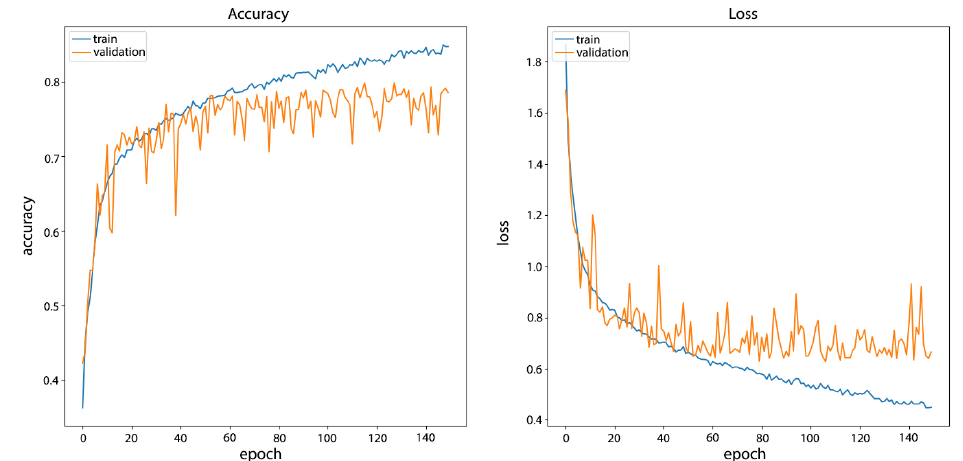
Figure 7. CNN Model_F1 training results on UTKFace filtered dataset without plotted landmarks.